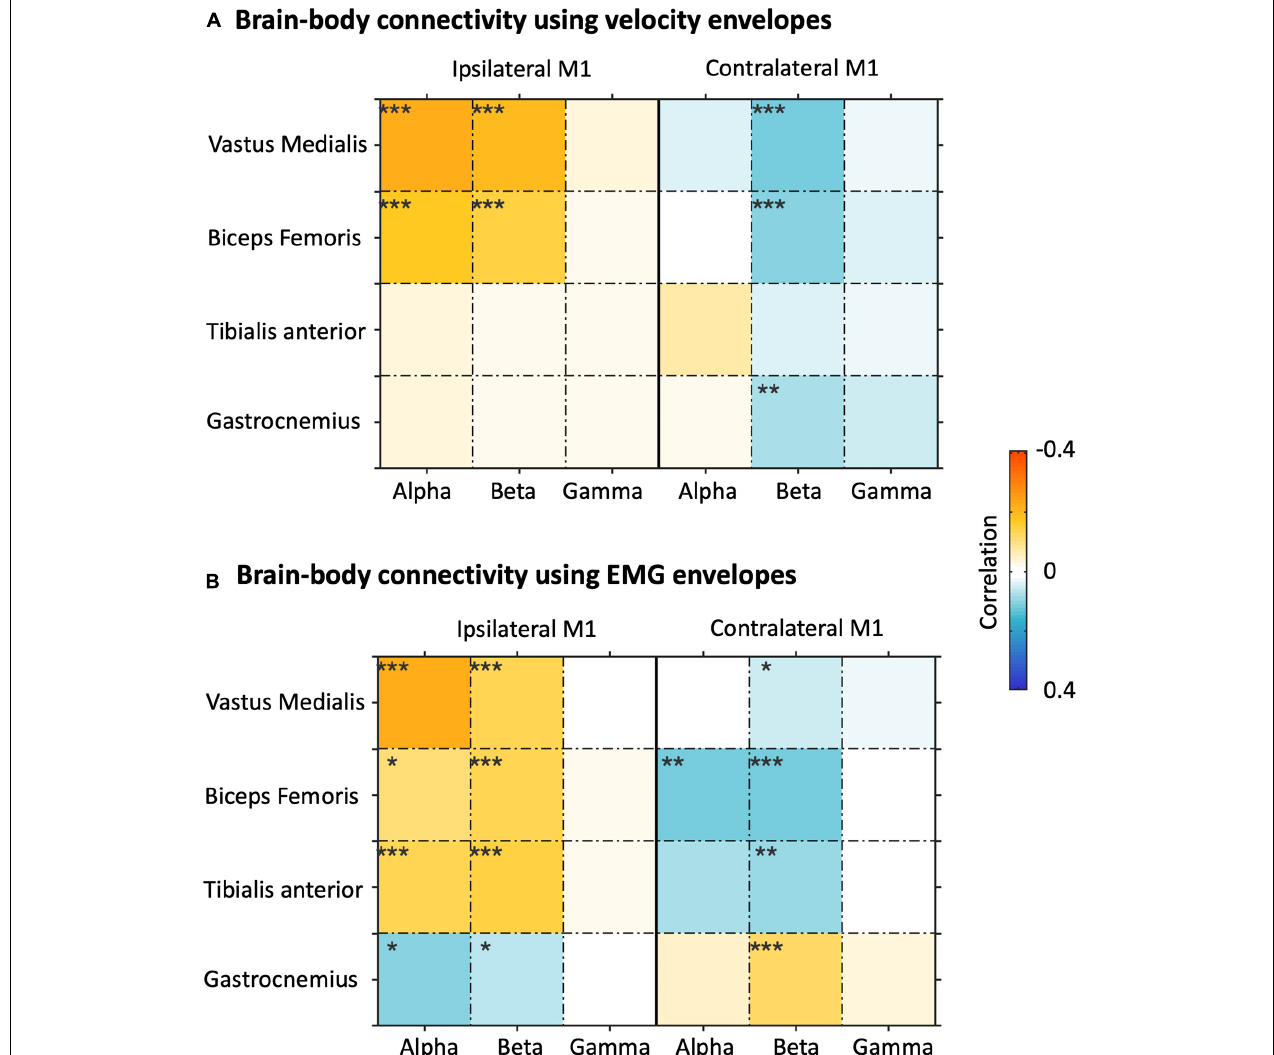
FIGURE 8 | Analysis of brain-body connectivity for ipsilateral and contralateral primary motor cortex (M1), in alpha, beta, and gamma frequency bands. (A) Brain-body connectivity assessed using envelopes of reconstructed neural signals and velocity envelopes. (B) Brain-body connectivity assessed using envelopes of reconstructed neural signals and EMG envelopes. *p FDR < 0 . 05 ; **p FDR < 0 . 01; ***p FDR < 0 .